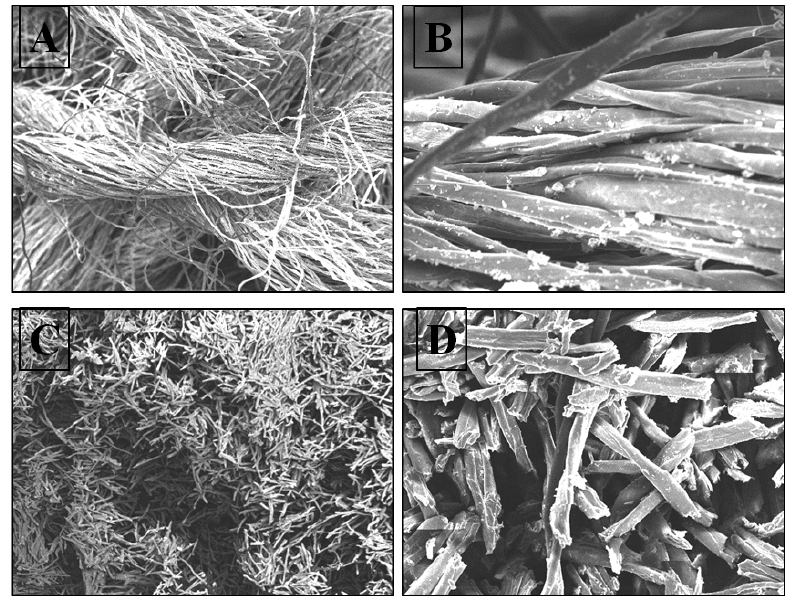
Figure 6. SEM micrographs of the treated and untreated cellulosic fiber waste, ( A ) untreated fiber waste at 200× magnification, ( B ) untreated fiber waste at 300× magnification, ( C ) treated fiber waste at 200× magnification, and ( D ) treated fiber waste at 300× magnification.